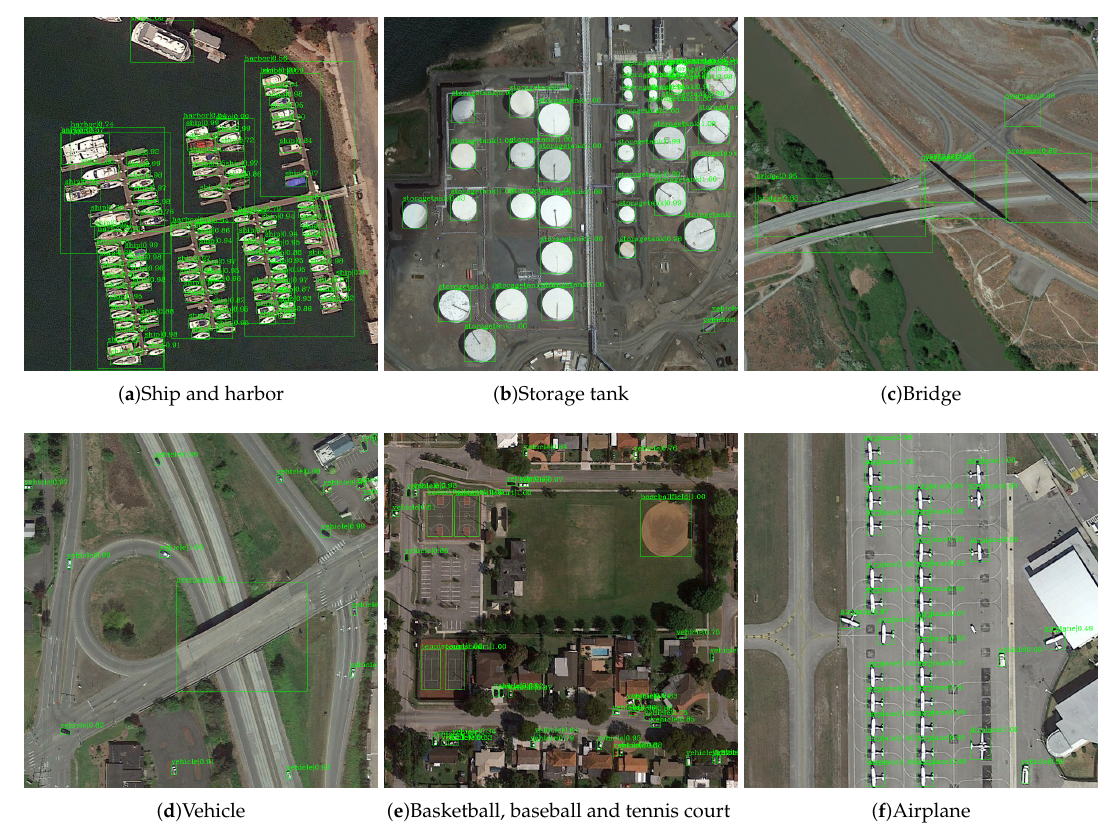
Figure 7. The samples of detection results of the proposed methods.